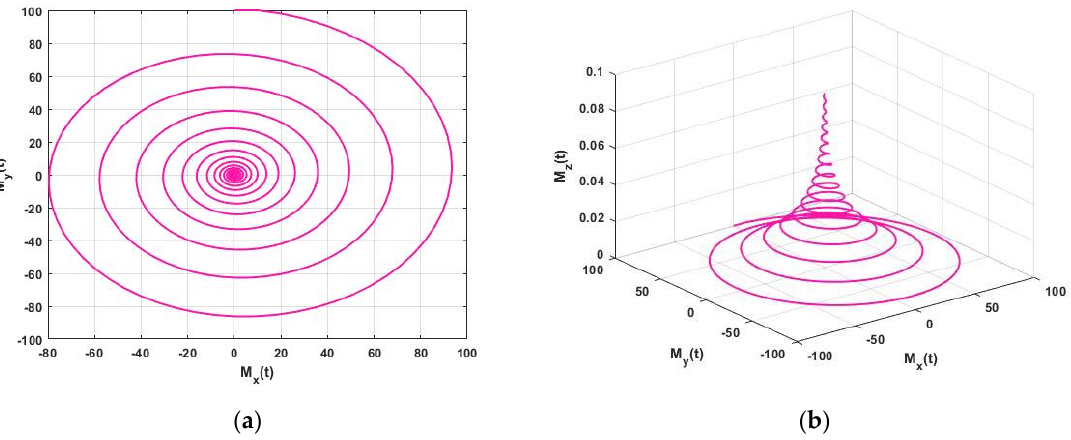
Figure 4. Approximate solution ( a ) 2D Plot and ( b ) 3D Plot of the FNMRF system for α = β = η = 1.0, 𝑀 (cid:2868) (cid:3404) 1 and initial condition (cid:4672)𝑀 (cid:3051) (cid:4666)0(cid:4667), 𝑀 (cid:3052) (cid:4666)0(cid:4667), 𝑀 (cid:3053) (cid:4666)0(cid:4667)(cid:4673) (cid:3404) (cid:4666)0,100,0(cid:4667) for 𝑇 (cid:3046)(cid:3036)(cid:3040) (cid:3404) 0.1 s .